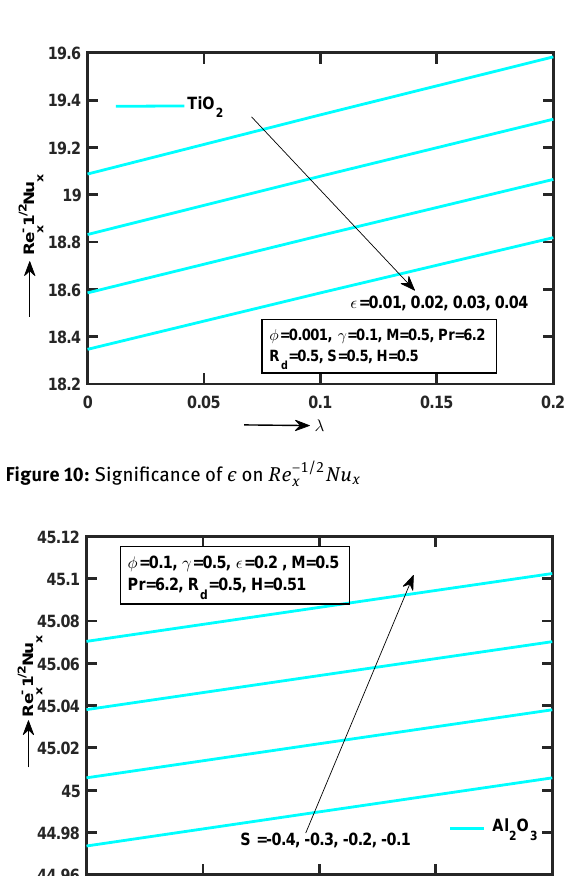
Figure 12: Significance of Pr on Re